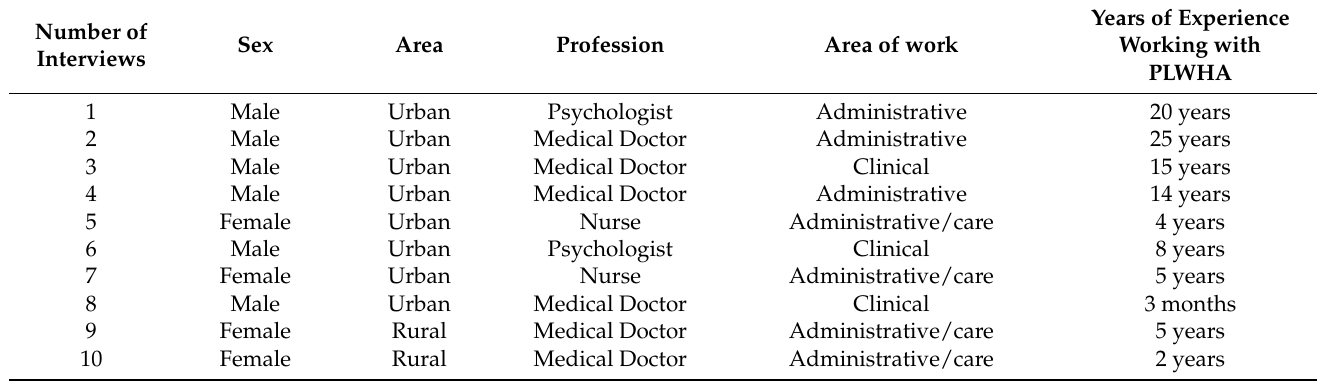
Table 2. Participants’ type of organization and years of experience working with people living with HIV/AIDS (PLWHA).